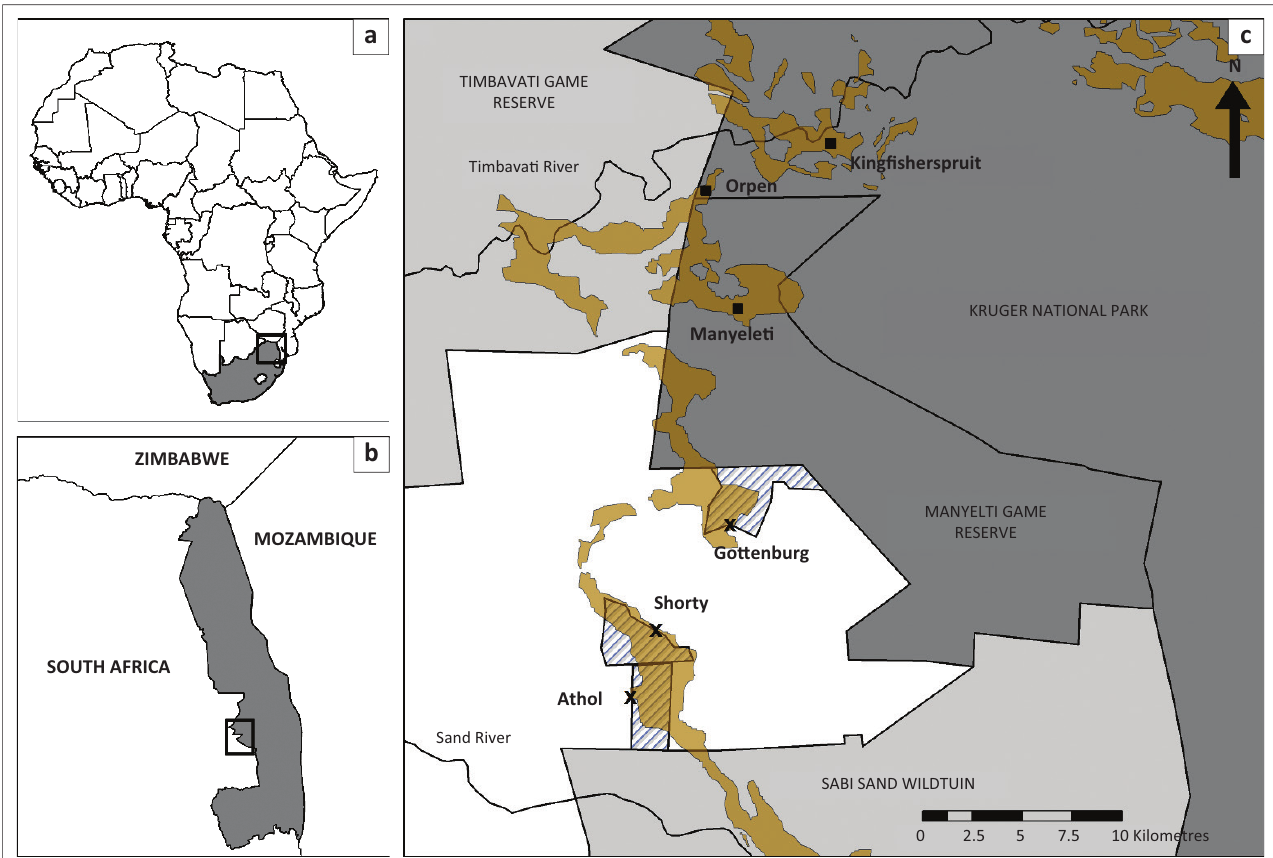
FIGURE 1: Map showing the study area. (a) South Africa, (b) the north-eastern region of South Africa around the Kruger National Park (in grey) and (c) the locations of the three sites within the protected areas (Kruger National Park and Manyeleti Game Reserve) and outside the protected areas in the communal rangelands (Athol, Gottenburg and Shorty). The brown colour represents the extent of Gabbro soil intrusion in the area (Mpumalanga Department of Agriculture and Land Administration 1997). At each site, three transects were set up to sample avian diversity and vegetation characteristics. Dark grey areas represent government-run protected areas, light grey areas represent privately run protected areas and areas in grey hatching represent cattle camps in communal rangelands used in this study. Areas in white represent communally managed